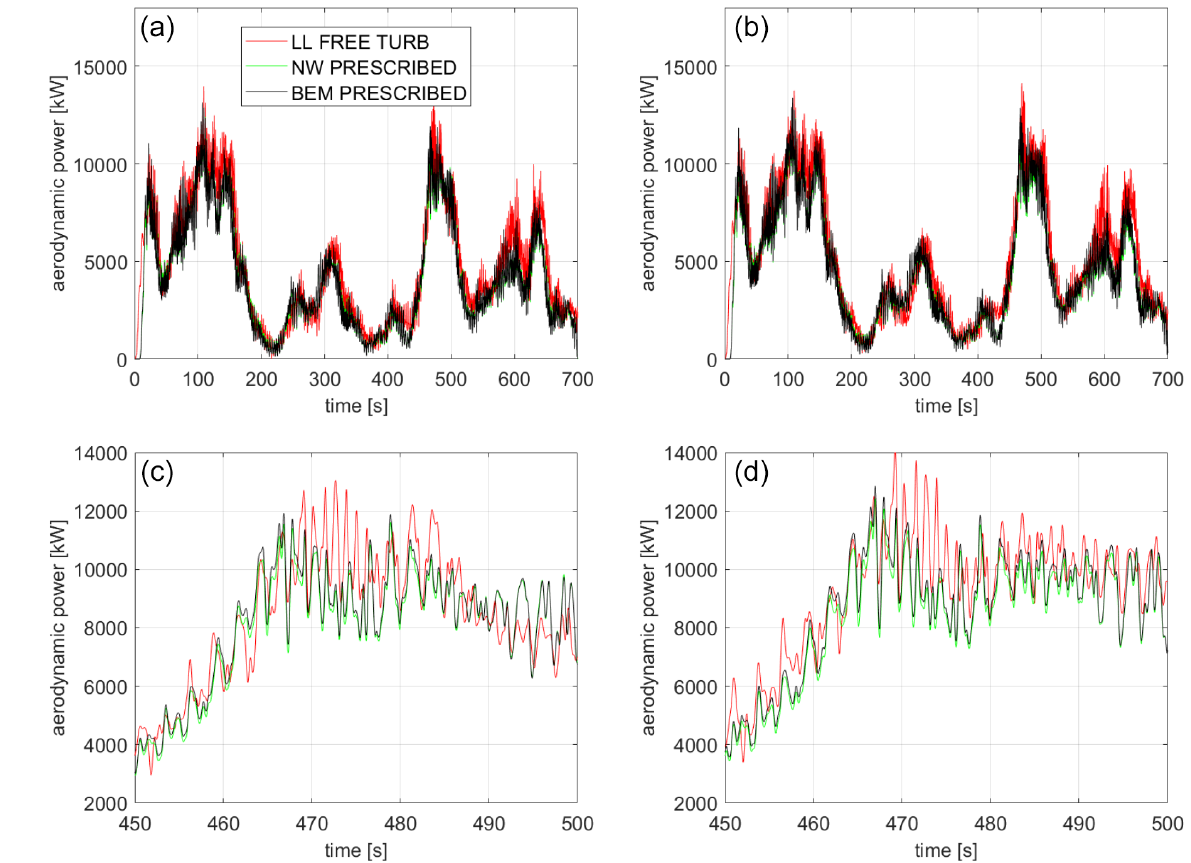
Figure 16. Aerodynamic power signal (a,c) baseline and (b,d) optimized design. (a,b) Full simulation time and (c,d) zoom-in for a 50s time